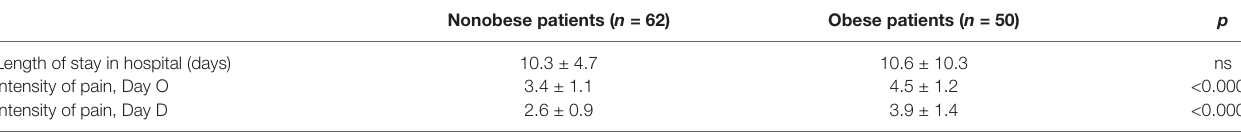
TABLE 2 | Length of stay in hospital and intensity of pain in the surgically treated obese and nonobese lung cancer patients.